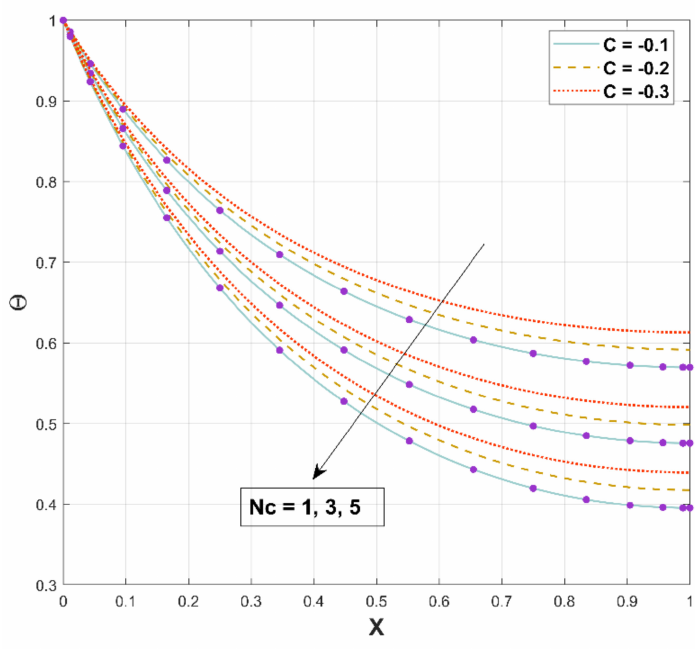
Figure 9. Upshot of Nc on Θ .